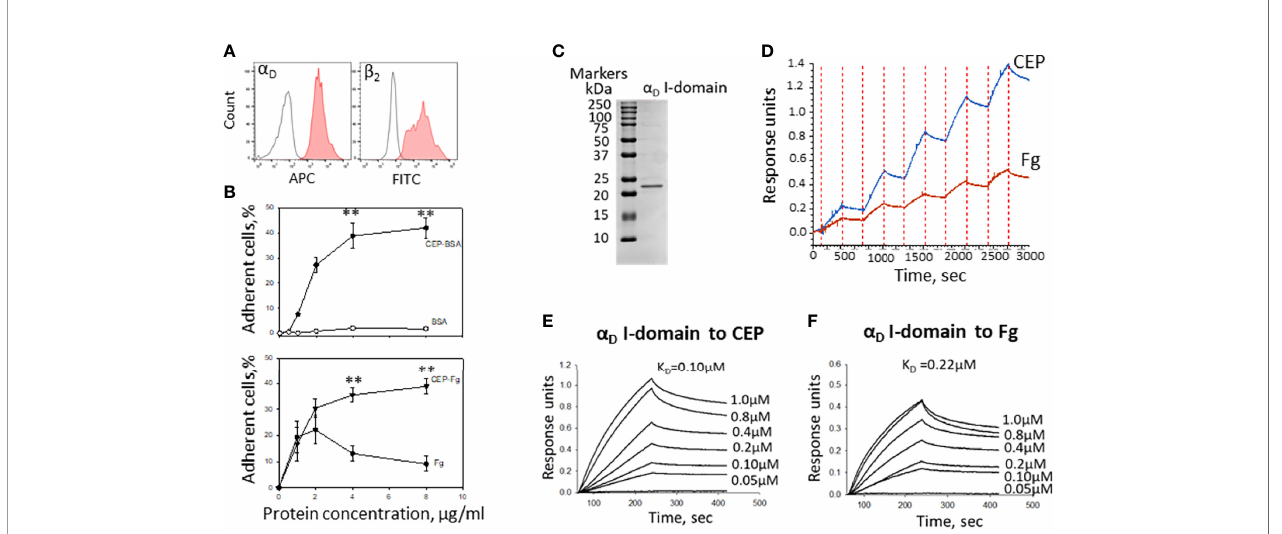
FIGURE 6 | The binding properties of CEP exceed the binding properties of natural a D b 2 ligands. (A) The expression of integrins a D and b 2 on the surface of HEK293-transfected cells. After isolation, cells were stained with anti- a D polyclonal antibody and anti- b 2 monoclonal antibody, followed by staining with donkey-anti- rabbit Alexa 647 and donkey-anti-mouse Alexa 488 secondary antibodies. Control is shown in open histogram. (B) Different concentrations of CEP-BSA and BSA (Upper panel) or CEP- fi brinogen (CEP-Fg) and Fg (lower panel) were immobilized on a 96-well plate for 3 h at 37°C. Fluorescently labeled a D b 2 HEK293-transfected cells were added to the wells and cell adhesion was determined after 30 min in a fl uorescence plate reader. A summary result from 4-6 experiments. Data are presented as mean ± SEM **p < 0.01. (C) Isolated a D I-domain binds to CEP in biolayer interferometry assays. SDS-PAGE of generated I-domain. a D active (D 122 - K 314 ) I-domain was isolated from soluble fractions of (E) coli lysates and puri fi ed using af fi nity chromatography. The protein purity was assessed by SDS-PAGE on 4- 15% gradient gel under non-reducing conditions followed by staining with Coomassie Blue. Representative pro fi les of the biolayer interferometry responses for a D binding to the immobilized CEP-BSA and Fibrinogen (Fg). (D) Single cycle kinetic of a D I-domain binding (concentrations ranging from 24-750 nM) to CEP-BSA and Fg coupled to AR2G biosensor. (F) Steady state analysis of a D I-domain binding to CEP (E) and Fg (F) (concentrations ranging from 50-1000 nM). The K D of binding was calculated using DataAnalysis HT11.0 software